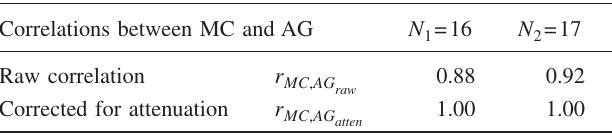
TABLE II. Correlations between students’ MC score and their AG score. These results imply that the students’ multiple-choice score are indeed consistent with their scores given by instructors grading their written